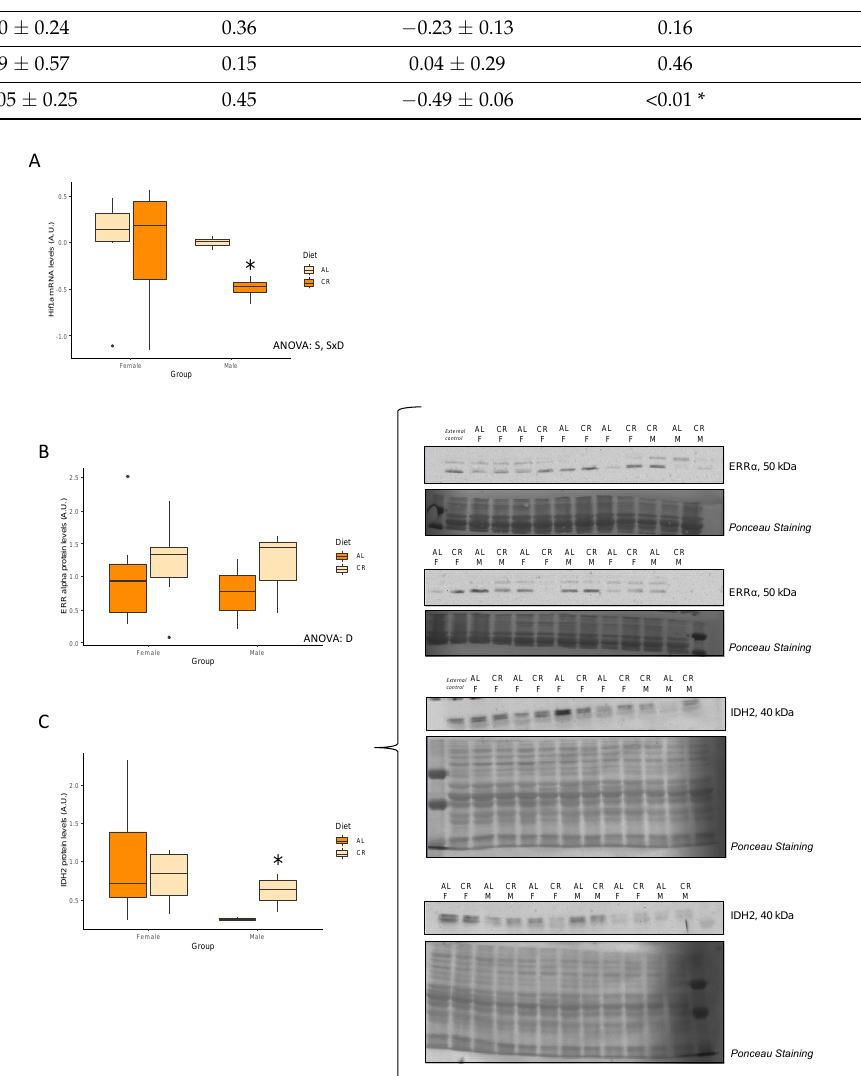
Figure 6. Levels of key nutrient-sensing pathways markers. Boxplots showing ( A ) the mRNA levels of Hif1a , ( B ) the protein levels of ERRα and ( C ) the protein levels of IDH2, and representative bands of the Western blot. Two-way ANOVA was performed to assess for significance. SxD indicates interactive effect between sex and diet, D indicates diet differences; AL: ad libitum; CR: caloric restriction; F: female; M: male. * Significant difference between calorie-restricted and control group.